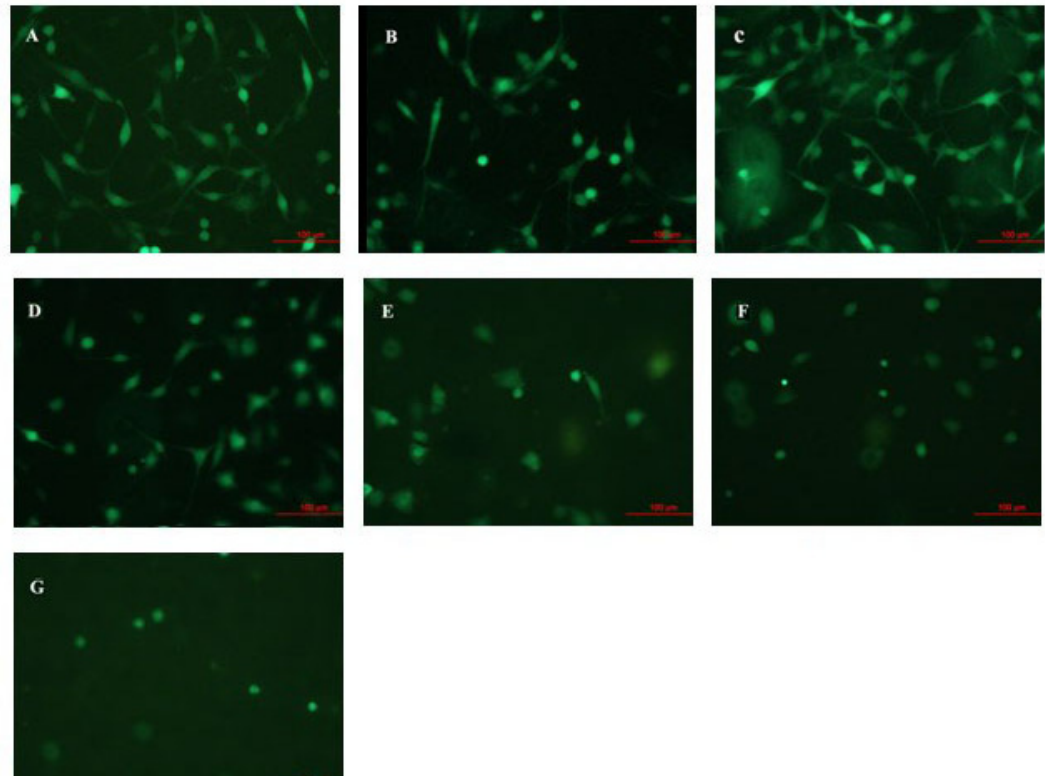
Figure 3. The growing states of C6 glioma cell lines under the fluorescence microscope after nanotube array of different shapes (20 times being cultured 24 h on the surface of TiO 2 magnification). ( A ) Plastic sheet prepared from polylysine; ( B ) Ti; ( C ) 15 nm-TNT; ( D ) 30 nm-TNT; ( E ) 50 nm-TNT; ( F ) 80 nm-TNT; ( G ) 100